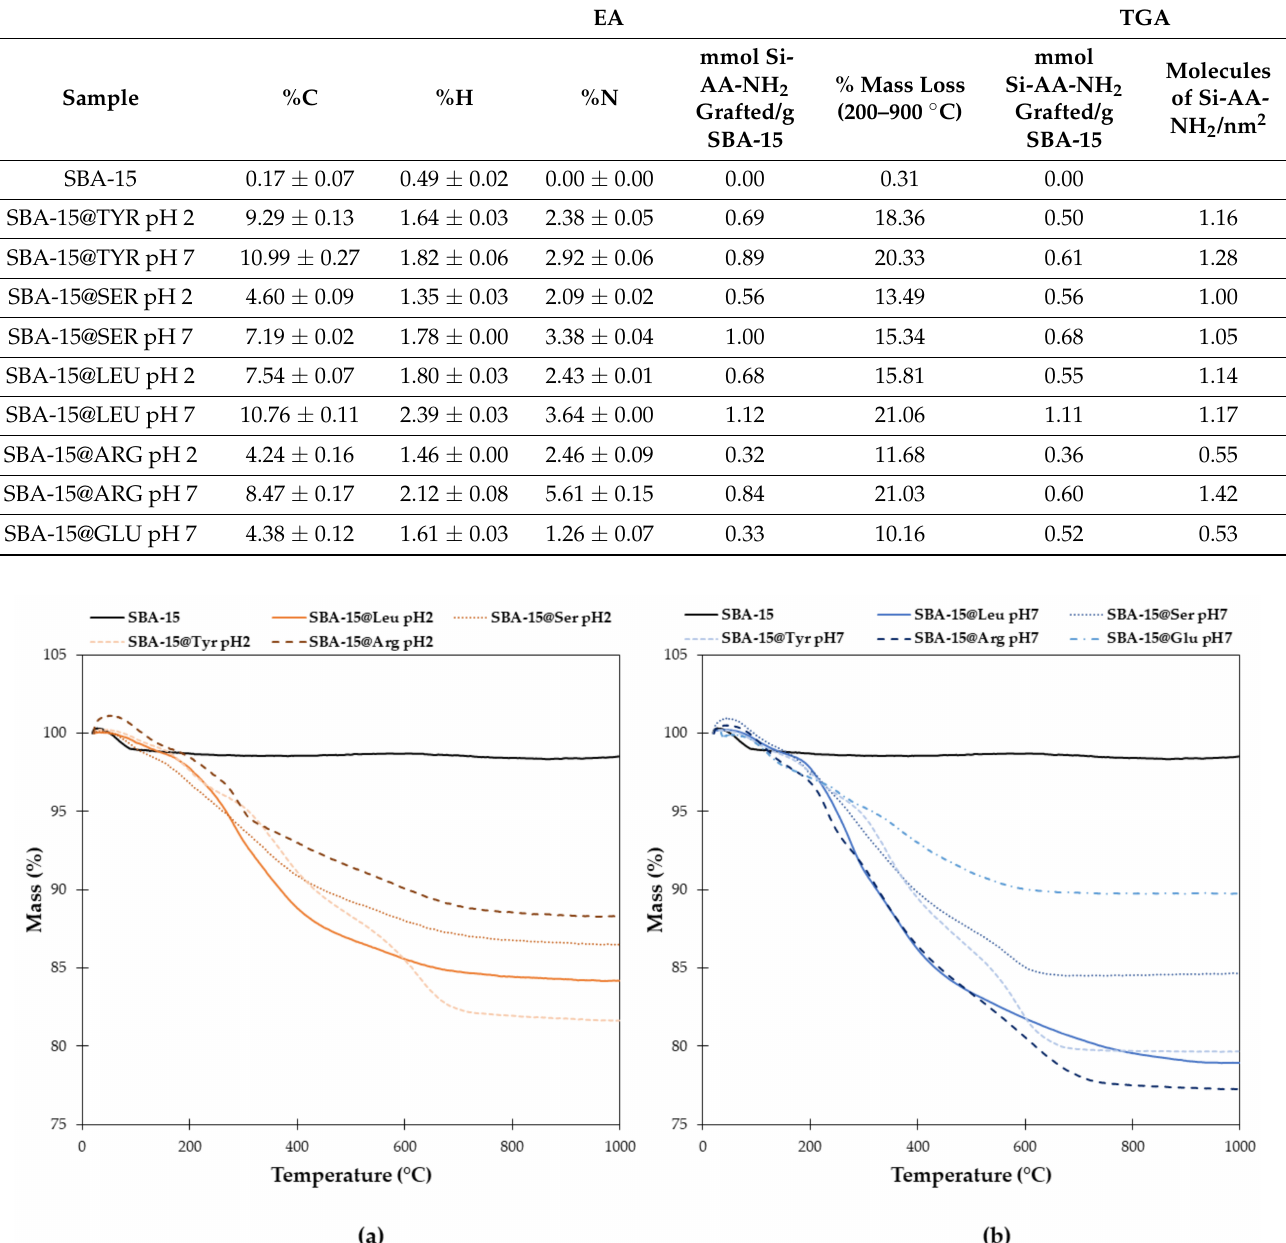
Table 3. Quantification of the Si-AA-NH 2 grafted onto the SBA-15 surface by EA and TGA.